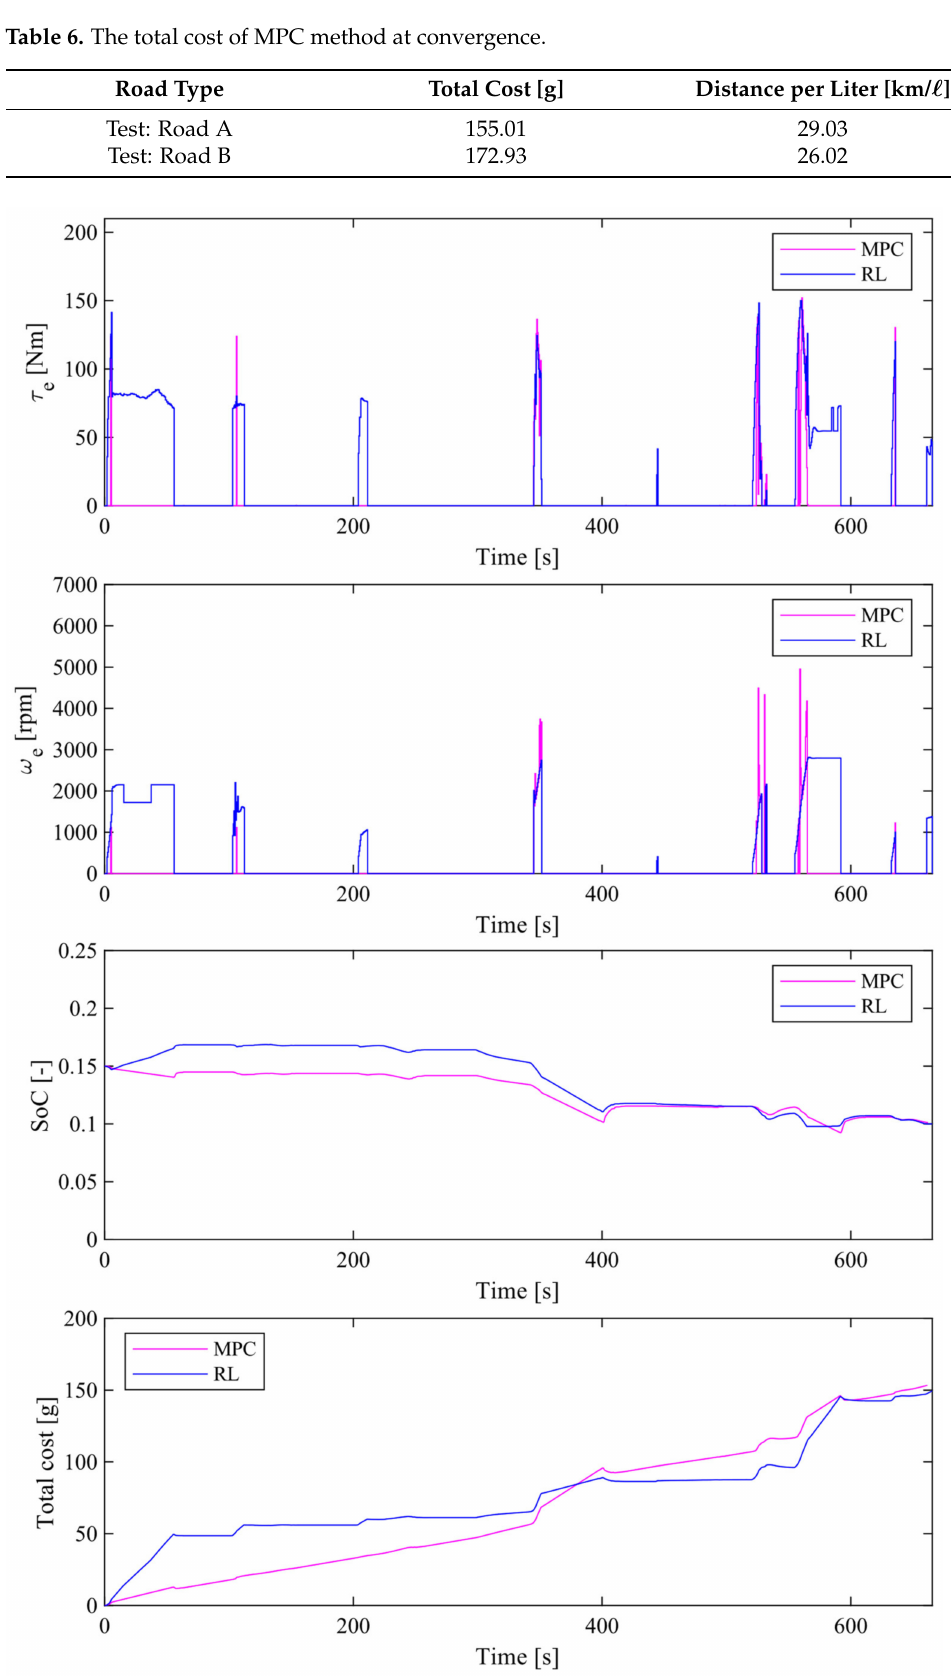
Figure 13. Simulation results of the proposed method and the MPC method for the test data on Road A (engine torque, engine speed, SoC , and total